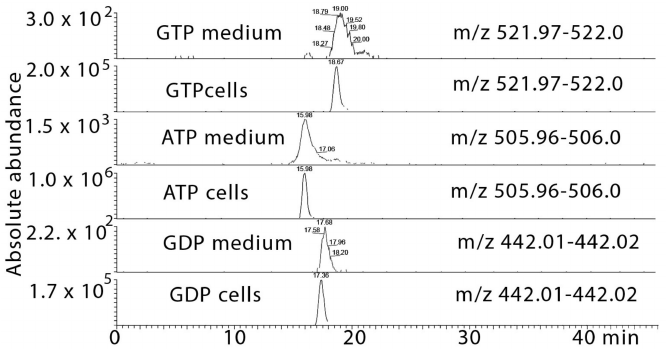
Figure 2. Extracted ion traces showing leakage of small amounts of high energy phosphates GTP, ATP and GDP into the growth medium in the treated